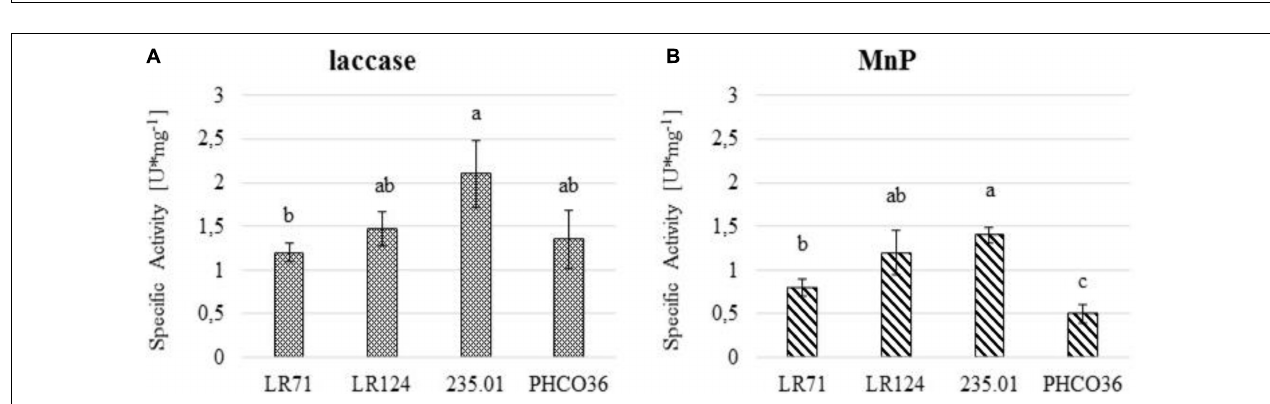
FIGURE 7 | Degradation of wood polymers of two grapevine cultivars [cv. Gewurztraminer (A,B) and cv. Teroldego (C,D) ] by two strains of Fmed [LR124 (A,C) and PHCO36 (B,D) ] after 30 and 90 days. Degradation is presented as a percentage of polymer loss, compared with the untreated wood, 30 and 90 days after inoculation with the fungus. Error bars on histograms represent the standard error of the mean. ANOVA analysis ( p ≤ 0.01) shows that strain and grapevine variety are factors which significantly influence all polymer degradation after 90 days.